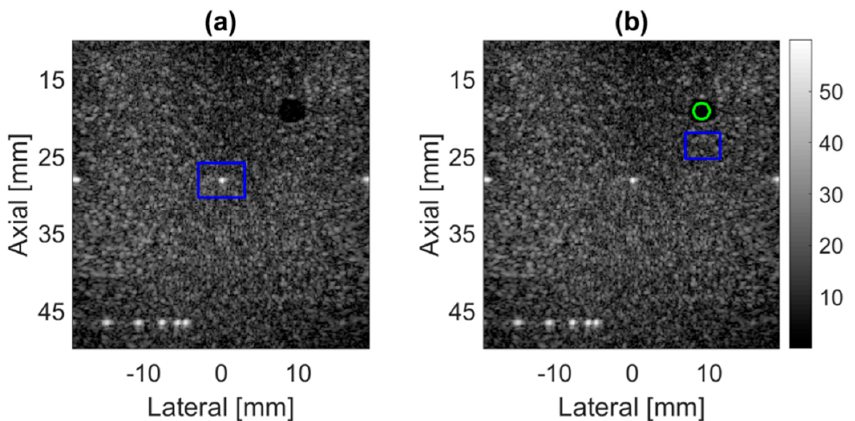
Figure 3. B-mode images of Prodigy dataset for measurement of image quality metrics. ( a , b ) Two different FOVs of the same experimental phantom.